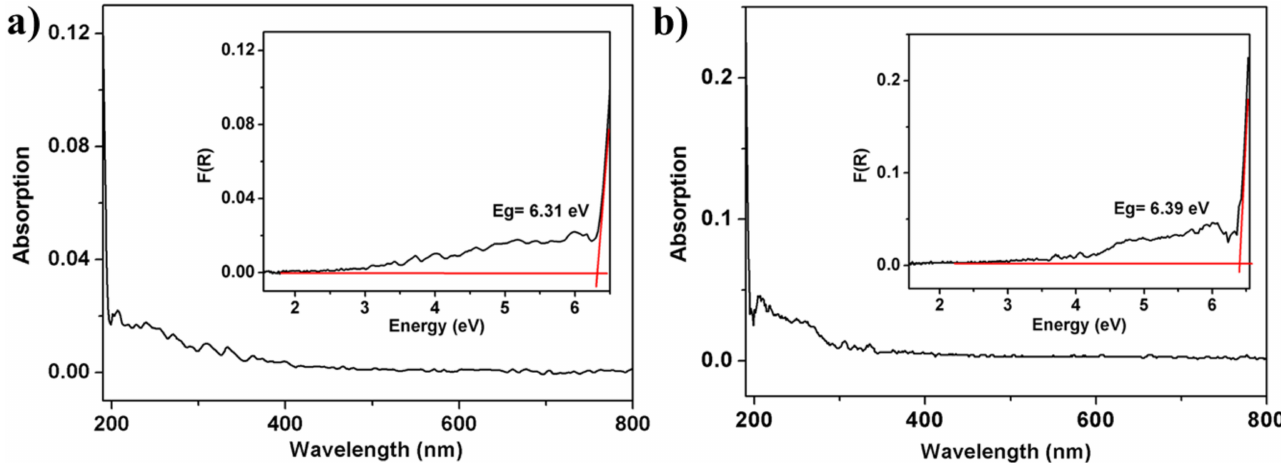
Figure 4. UV–Vis absorption spectra of 1 ( a ) and 2 ( b